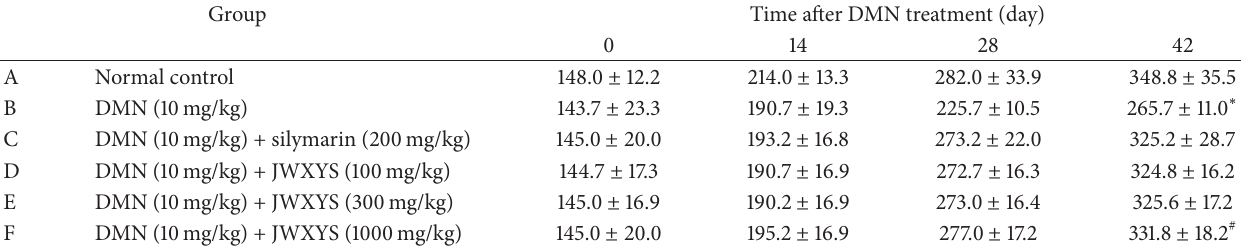
Table 1: Effects of JWXYS and silymarin on the body weights of rats with DMN-induced chronic liver injury. Group Time after DMN treatment (day) Normal